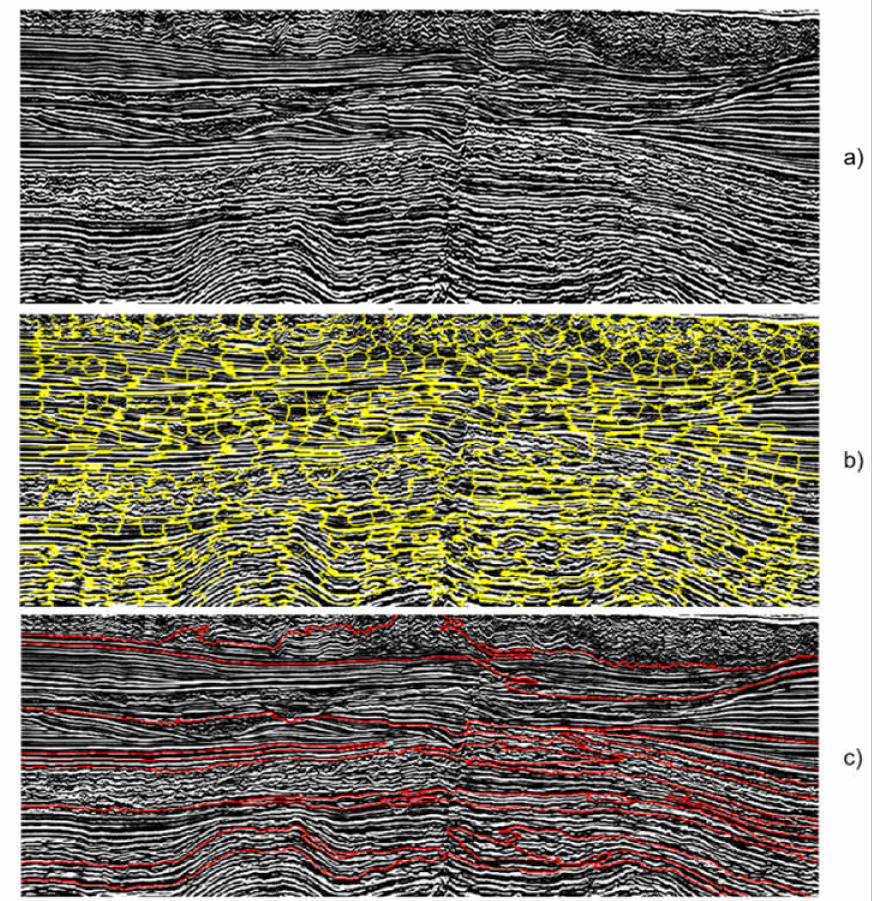
Figure 5. Example of results from the segmentation of the seismic (vertical slice) data ( a ) through the SLIC ( b ) and Watershed ( c )